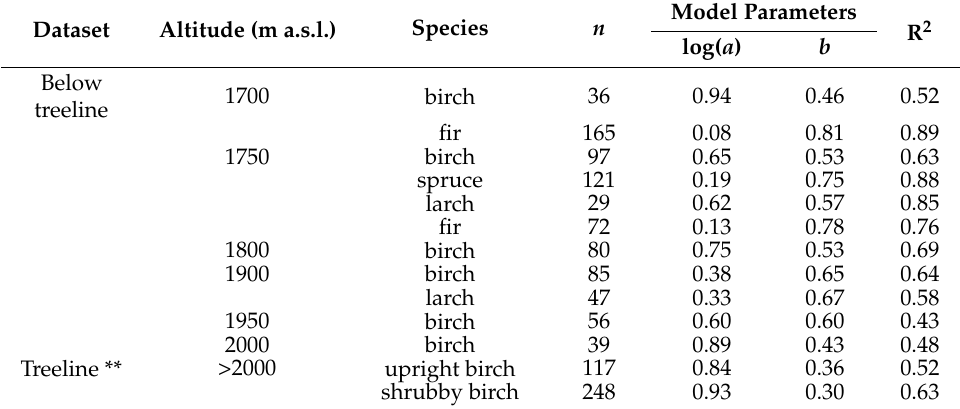
Model Parameters R 2 log( a )